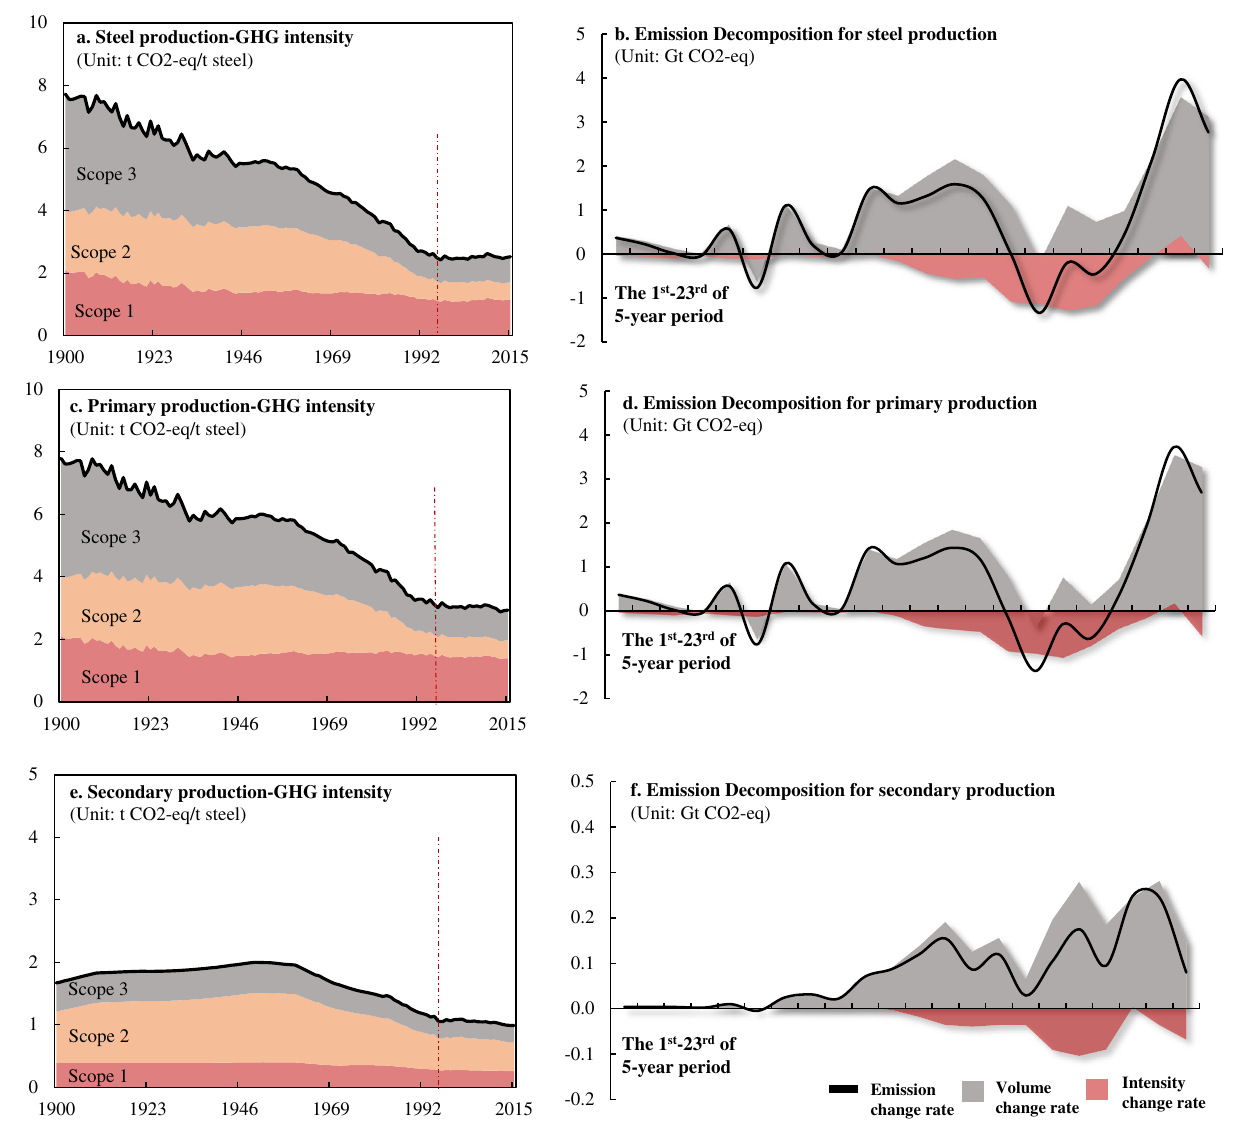
Fig. 4 Improvement in the steel process ef fi ciency and its linkages with production volume and GHG emission. a , c , e The historical GHG intensity evolution in scopes 1, 2 and 3 for the total, primary and secondary production routes respectively. The red dot line highlights the start of a staggering period (see Supplementary Information 1 Section S4.3). We further decomposed the factors of volume and intensity from total emission impact (see Supplementary Information 1 Section S4.2). b , d , f The changes in emissions, volume and intensity during the 1 st to 23 rd 5-year period for total, primary and secondary production routes,